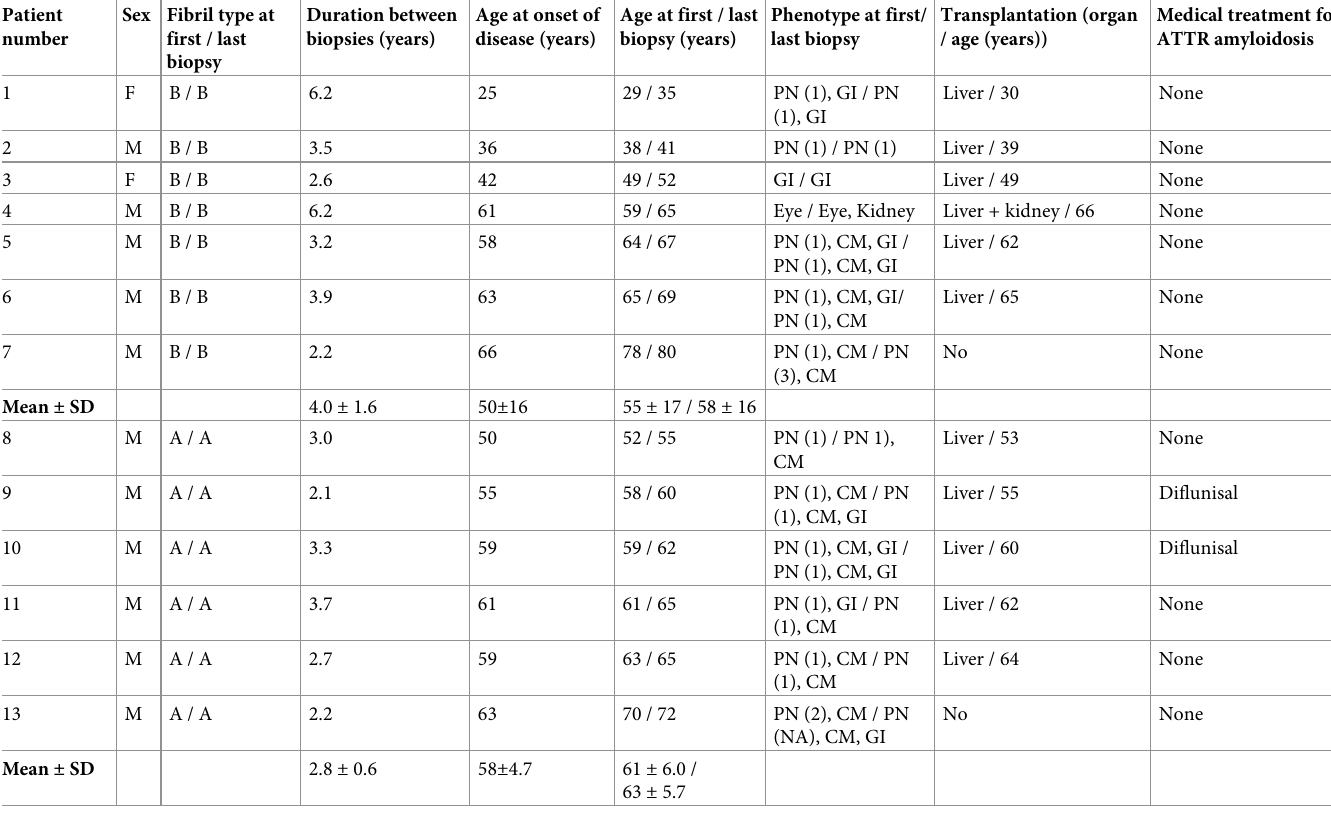
Table 1. Patients whose fibril type already had been determined in two